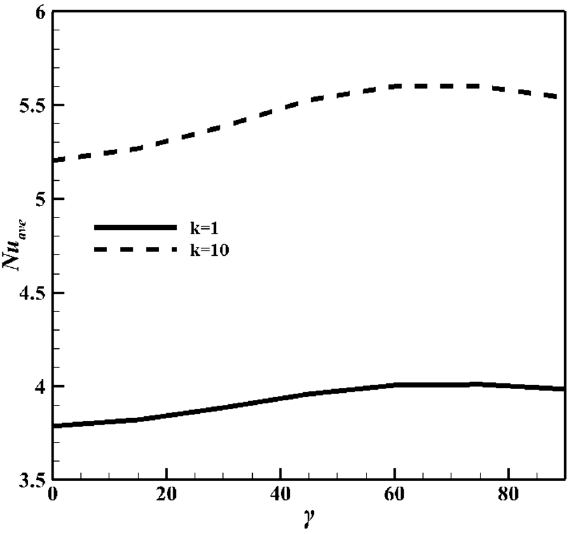
Figure 18. Average Nusselt number for different inclination angles of magnetic field, thermal conductivity ratios at Ra = 10 6 , Ha = 60, = 0.05, Ω = 500, and λ = ϕ